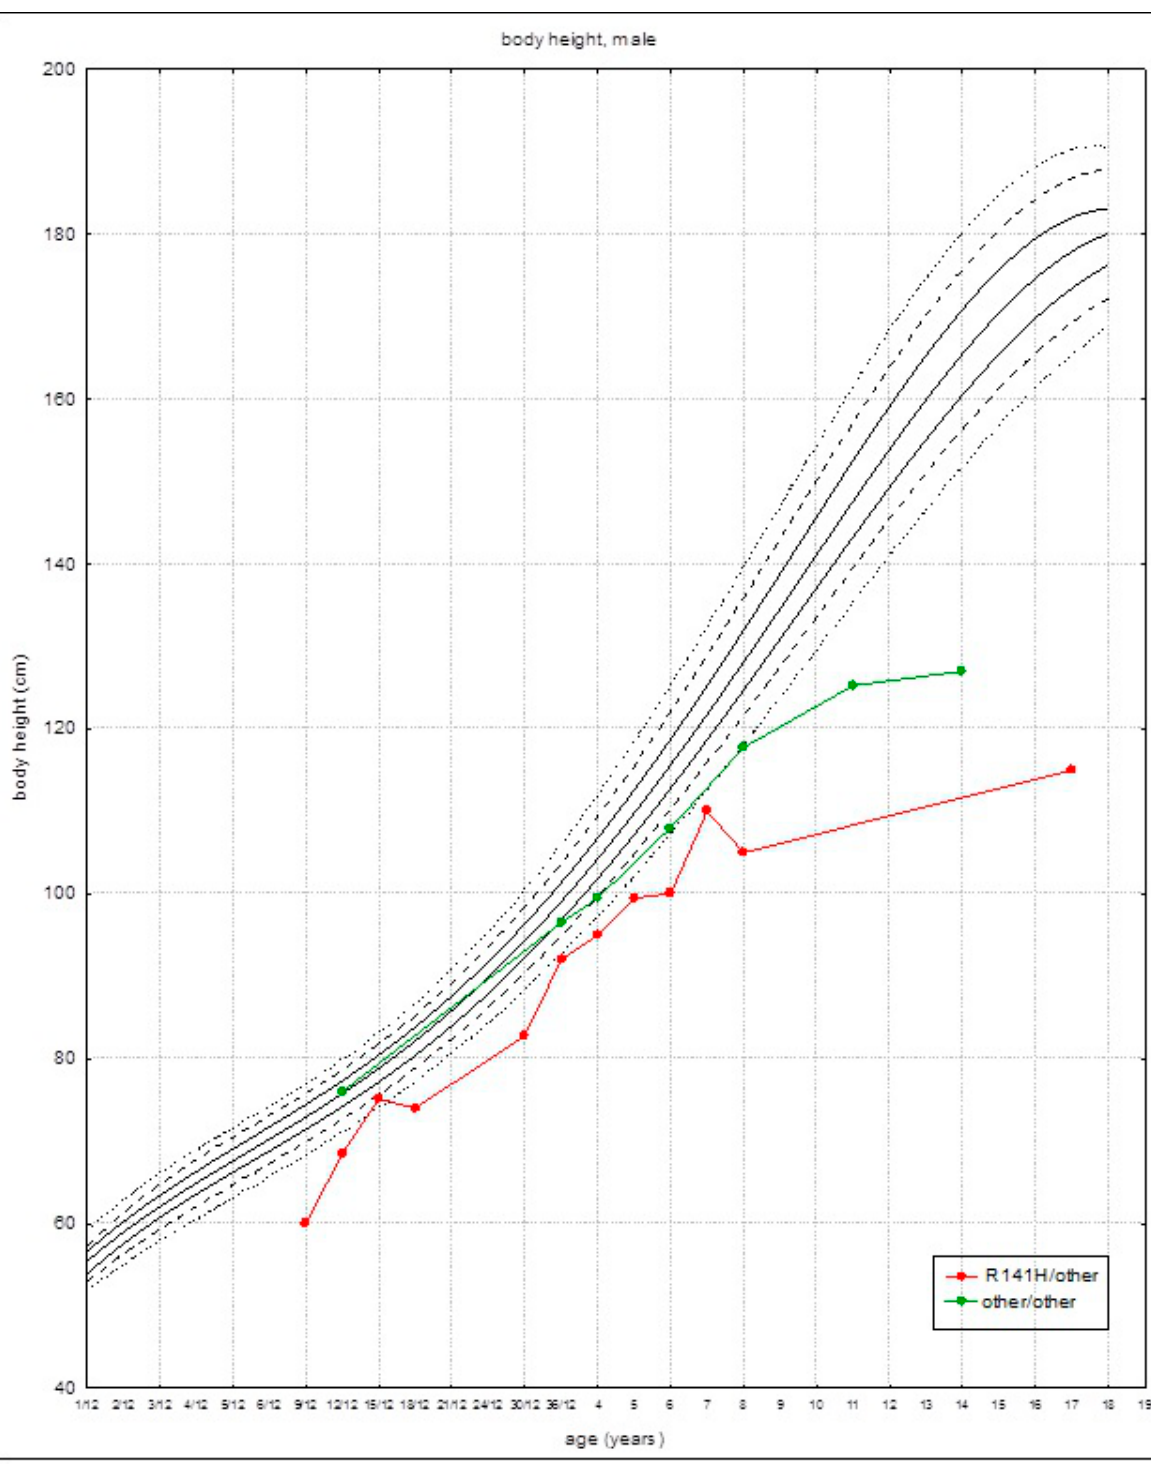
Figure 2. Growth curves (established on the average growth values) for patients with PMM2-CDG for the given genotypes: R141H/other (red marks) and other/other (green marks) on references growth charts for the healthy population.